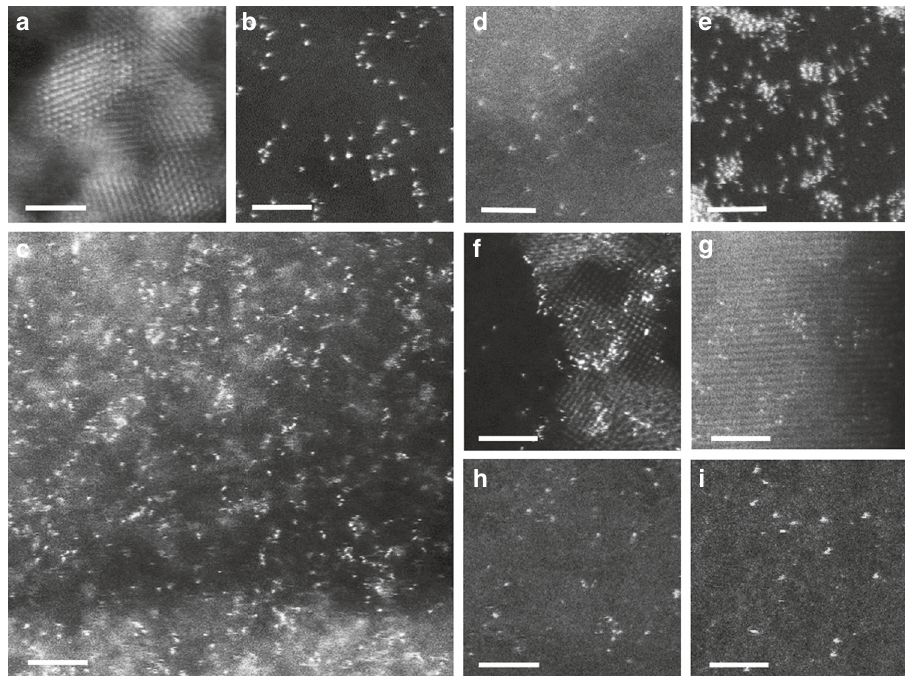
Fig. 2 HAADF-STEM images of Pt single atoms. a Pt nanocrystals with a size of ~2 nm formed by normal photochemical reduction of H 2 PtCl 6 aqueous solution. b Pt single atoms dispersed on ultrathin carbon fi lm, with each bright dot corresponding to one individual Pt atom, with a size of ~0.1 nm. c Densely and homogeneously dispersed Pt single atoms on mesoporous carbon. d Pt 1 /MWCNTs, indicating that Pt existed completely as isolated single atoms. e Pt 1 /graphene, with concomitant Pt single atoms, nanoclusters and sub-nanometer clusters. f Atomically dispersed Pt on titanium oxide nanoparticles. g Pt single atoms attached on the surface of zinc oxide nanowires. h Ag and i Au single atoms prepared by a similar iced-photochemical route. (scale bar, 2